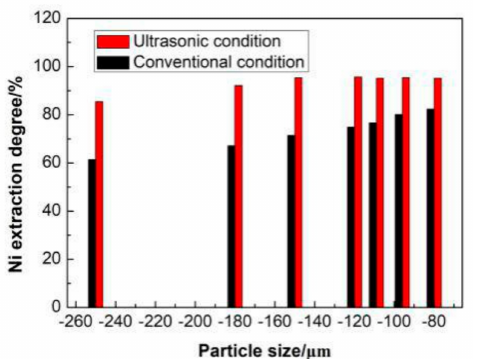
Figure 6. Effect of particle size on Ni extraction degree. Conventional: leaching temperature = 25 ◦ C, mass fraction of sulfuric acid = 15%, solid-liquid ratio = 1:7, stirring speed = 150 rpm, leaching time = 40 min. Ultrasonic: leaching temperature = 25 ◦ C, mass fraction of sulfuric acid = 15%, solid-liquid ratio = 1:7, ultrasonic power = 600 W, leaching time = 40 min.